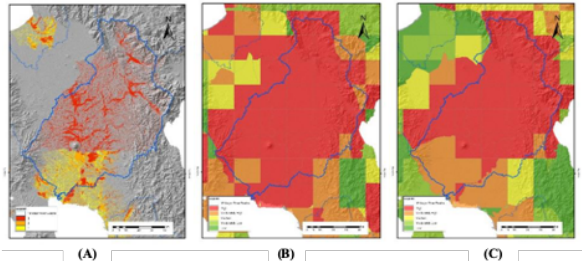
Figure 4. Pampanga RB maps of (A) flood hazard from the DREAM Project, (B) flood exposure, and (C) flood vulnerability.